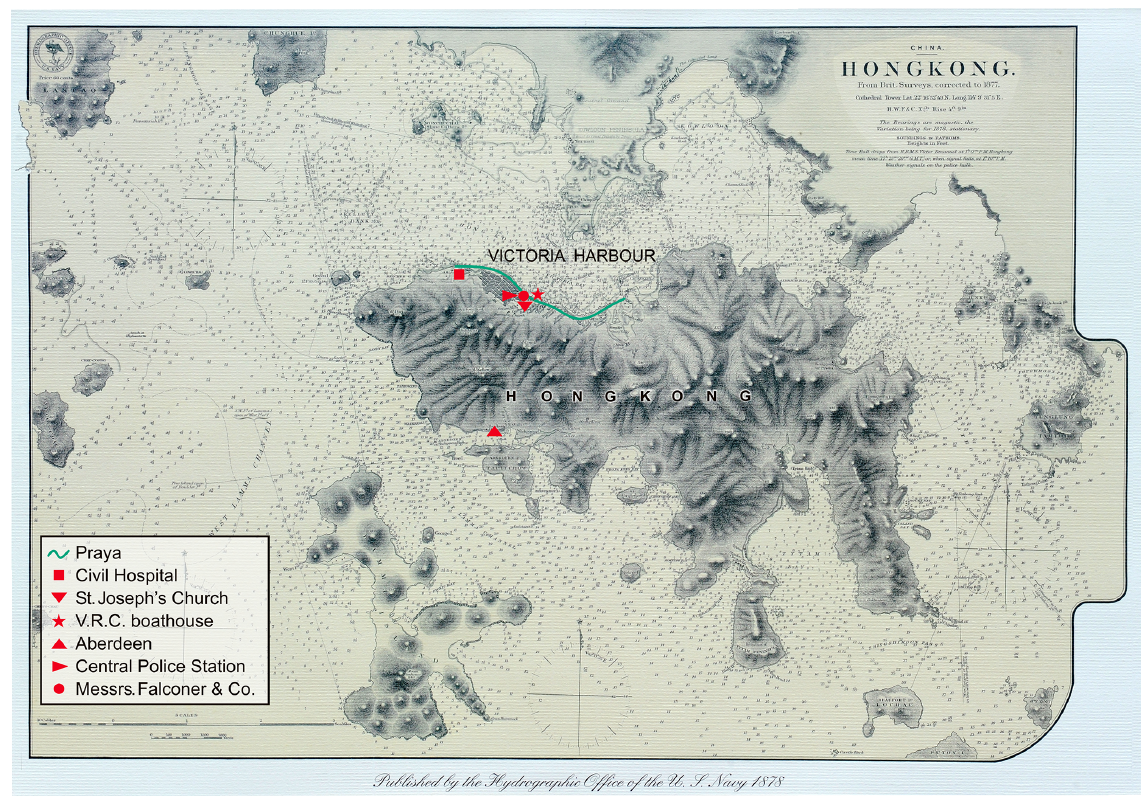
Figure 2. Historical Hong Kong map published by the Hydrographic Office of the UK Navy in 1878 (owned by Chi Ming Shun) showing the Praya along the northern coast of Hong Kong Island and the locations of the Civil Hospital, St. Joseph’s Church, the V.R.C. boathouse, Aberdeen, the Central Police Station, and Messrs. Falconer & Co. on Hong Kong